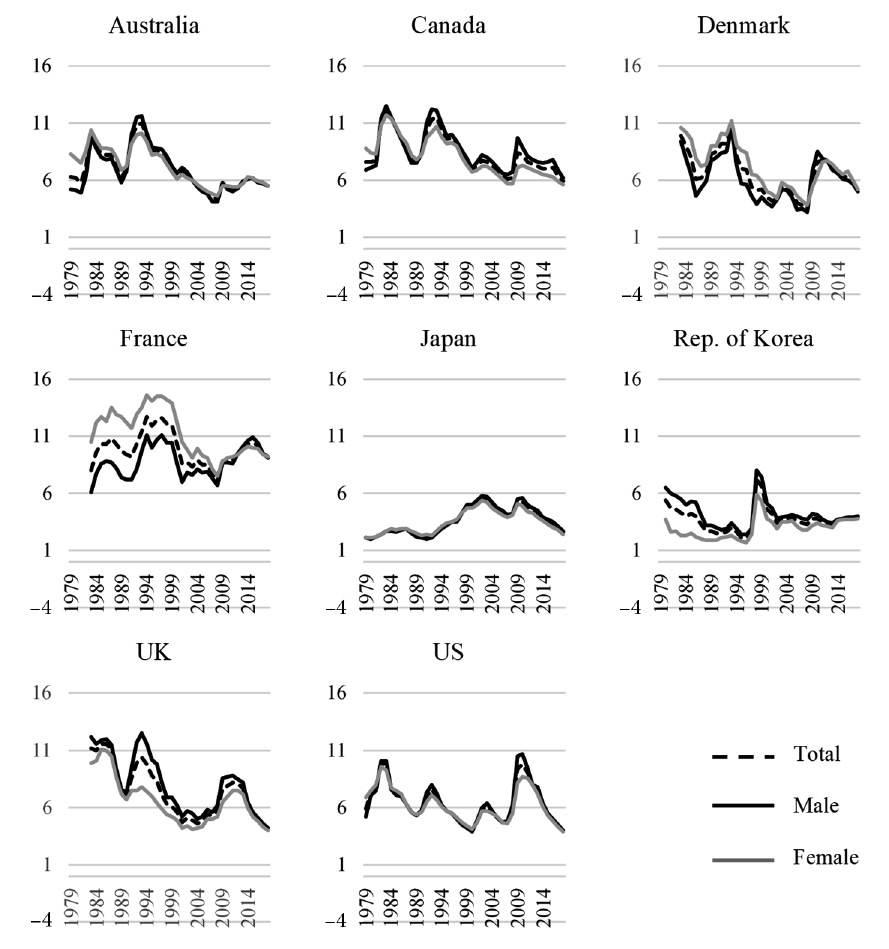
Figure 3. Unemployment rates of male and female (source: own calculations based on the ILO